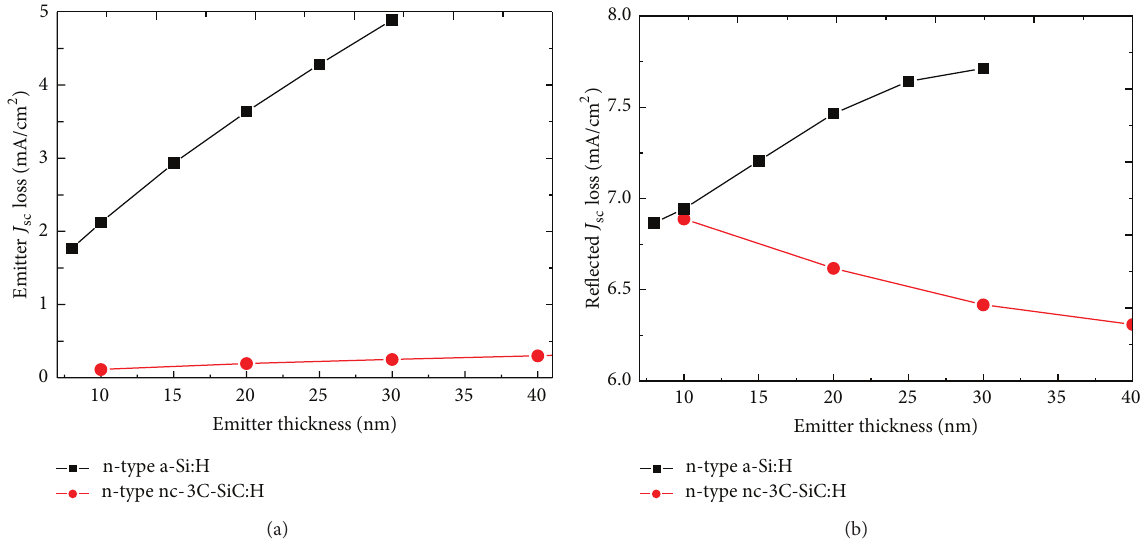
Figure 4: (a) The emitter current density loss as a function of the emitter thickness of the SHJ solar cell (b). The reflected current density loss as a function of emitter thickness for SHJ solar cell.